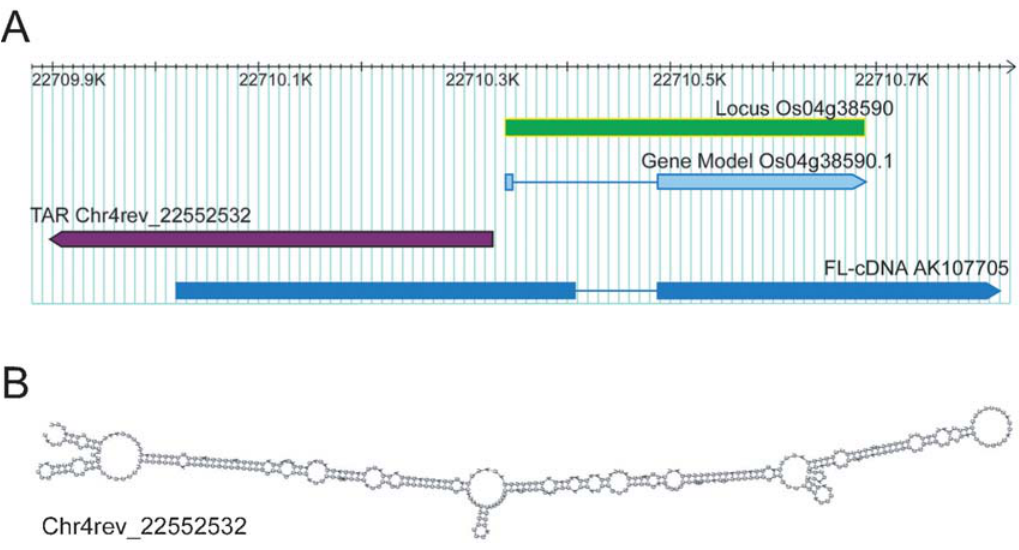
Figure 7. Analysis of 5 9 proximal antisense TARs. (A) Annotation of TAR Chr4rev_22552532 that locates in a divergent antisense orientation to the gene model Os04g38590. (B) Predicted secondary structure of the RNA transcript derived from the TAR Chr4rev_22552532. RNA secondary structure was predicted using RNAfold, which is available as part of the Vienna RNA Package.